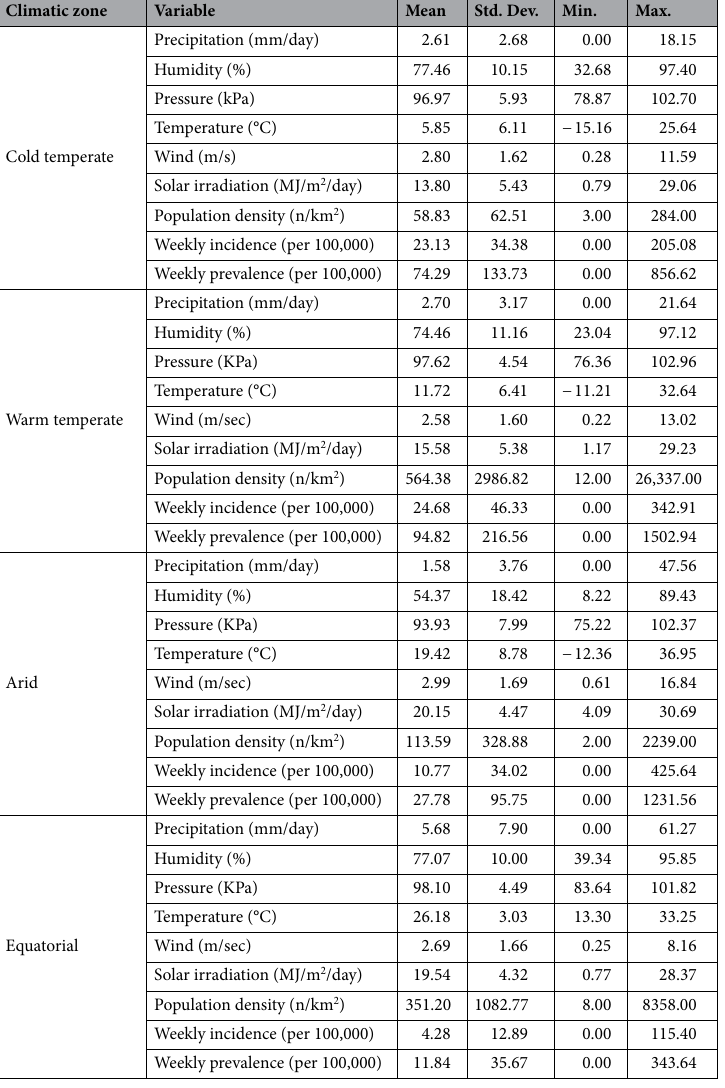
Table 1. Summary statistics of meteorological variables, weekly incidence and weekly prevalence of SARS- CoV-2, population density, by climatic zone, in the first 16 weeks of the infection, in 209